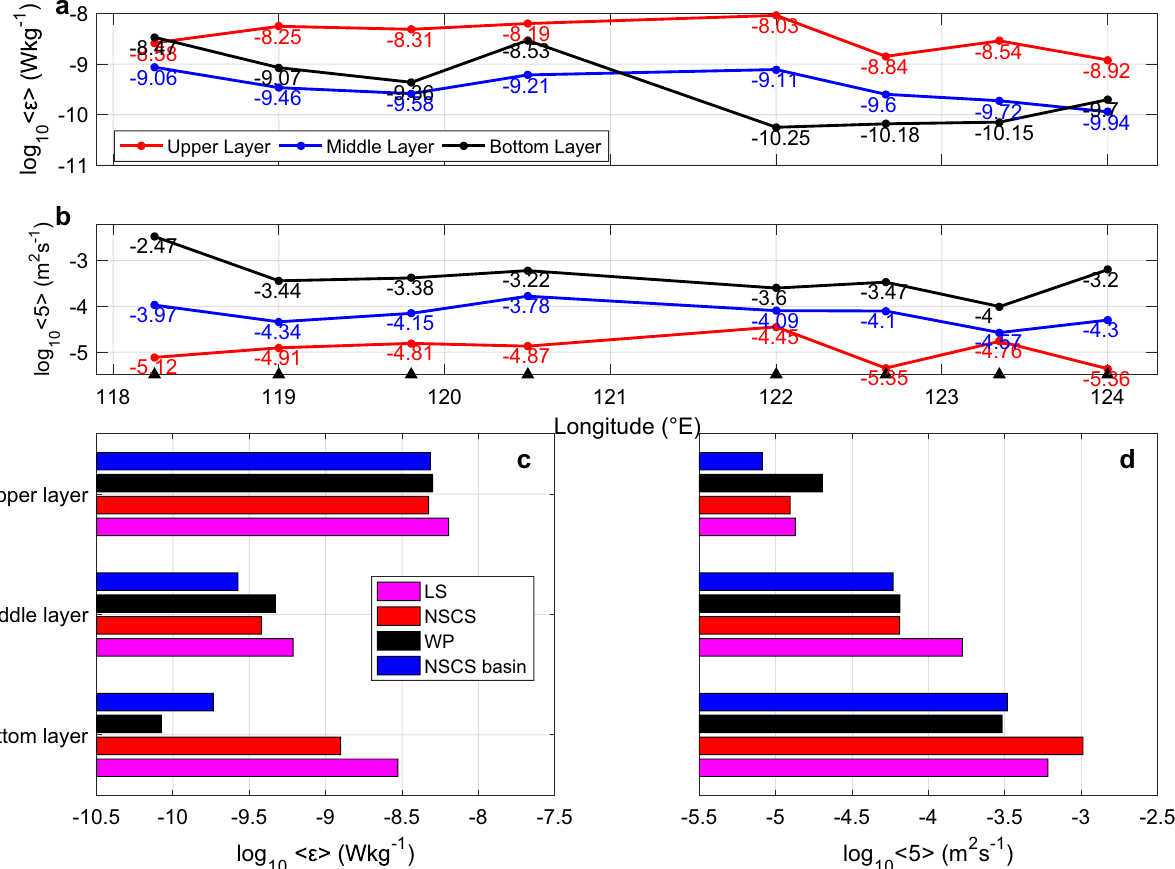
Figure 4. Zonal distribution of < ε > and < κ > ( a , b ) and comparison of averaged dissipation rates and diapycnal diffusivities for different areas ( c , d ) in each layer. The average values of the LS, WP and NSCS basin are calculated based on stations in the same color in Fig. 1. The NSCS includes stations of the NSCS slope and NSCS basin in Fig.